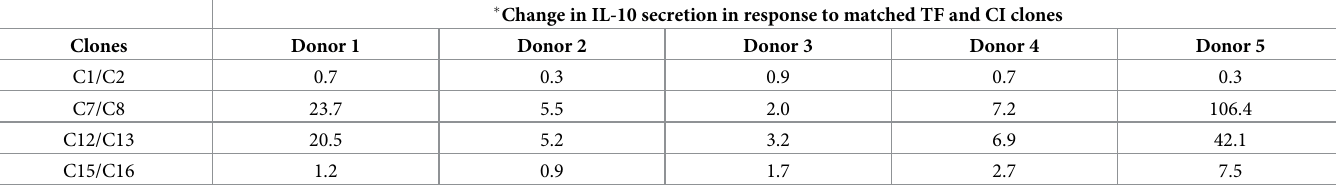
Table 2. Variation in IL-10 secretion by MDDC